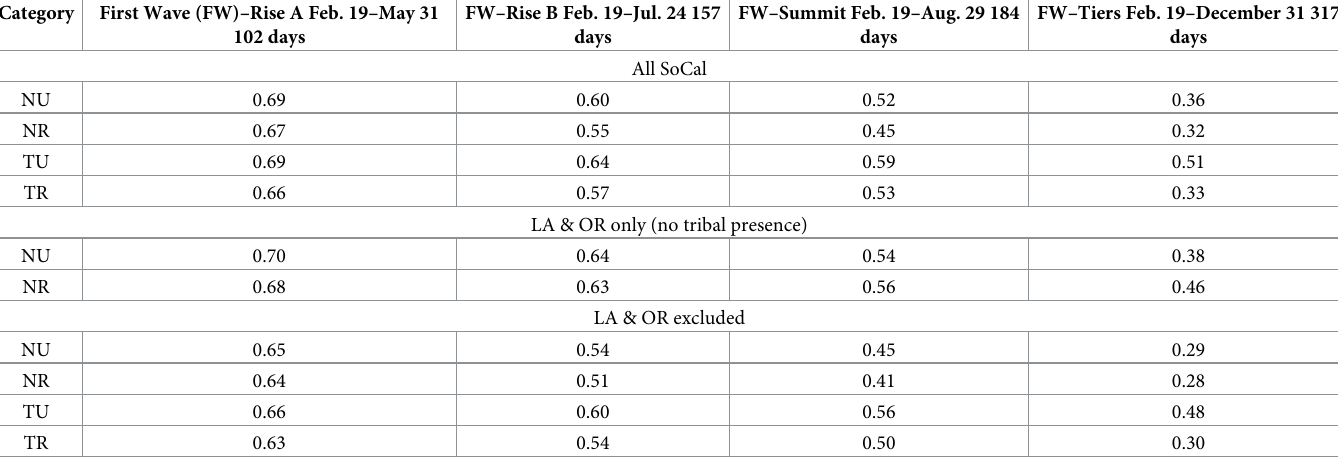
Table 5. Median correlation coefficients during characteristic time ranges using a 50% labeling scheme for tribal and rural areas.